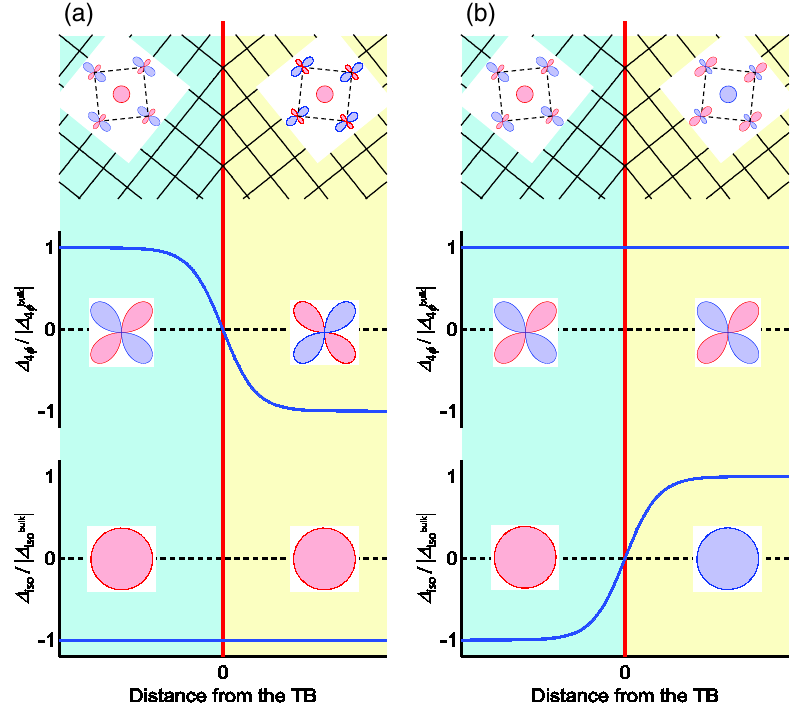
FIG. 4. Schematic illustration of the phases of the superconducting gaps across the TB shown by the red line. Top panel represents the iron lattice near the TB together with the momentum-space phase structure of the superconducting gaps opening at multiple Fermi cylinders, a hole cylinder at the center, and electron cylinders at the corner of the Brillouin zone (black broken square). Different colors (red and blue) denote different signs of the phase. We assume that the gap node exists on the electron cylinder and the sign reversal is between the main lobe of the gap on the electron cylinder and the gap on the hole cylinders, but the argument given in the text applies not only for this particular case but also for other cases. There are two possibilities: the phase structure is either fixed to the lattice (a) or flipped across the TB (b). In the former case, the nodal component Δ 4 ϕ should change its sign across the TB, whereas the sign of the isotropic component Δ (either due to the fully gapped Fermi cylinder or associated with the C 2 symmetry of the nodal gap) should be iso reversed in the latter